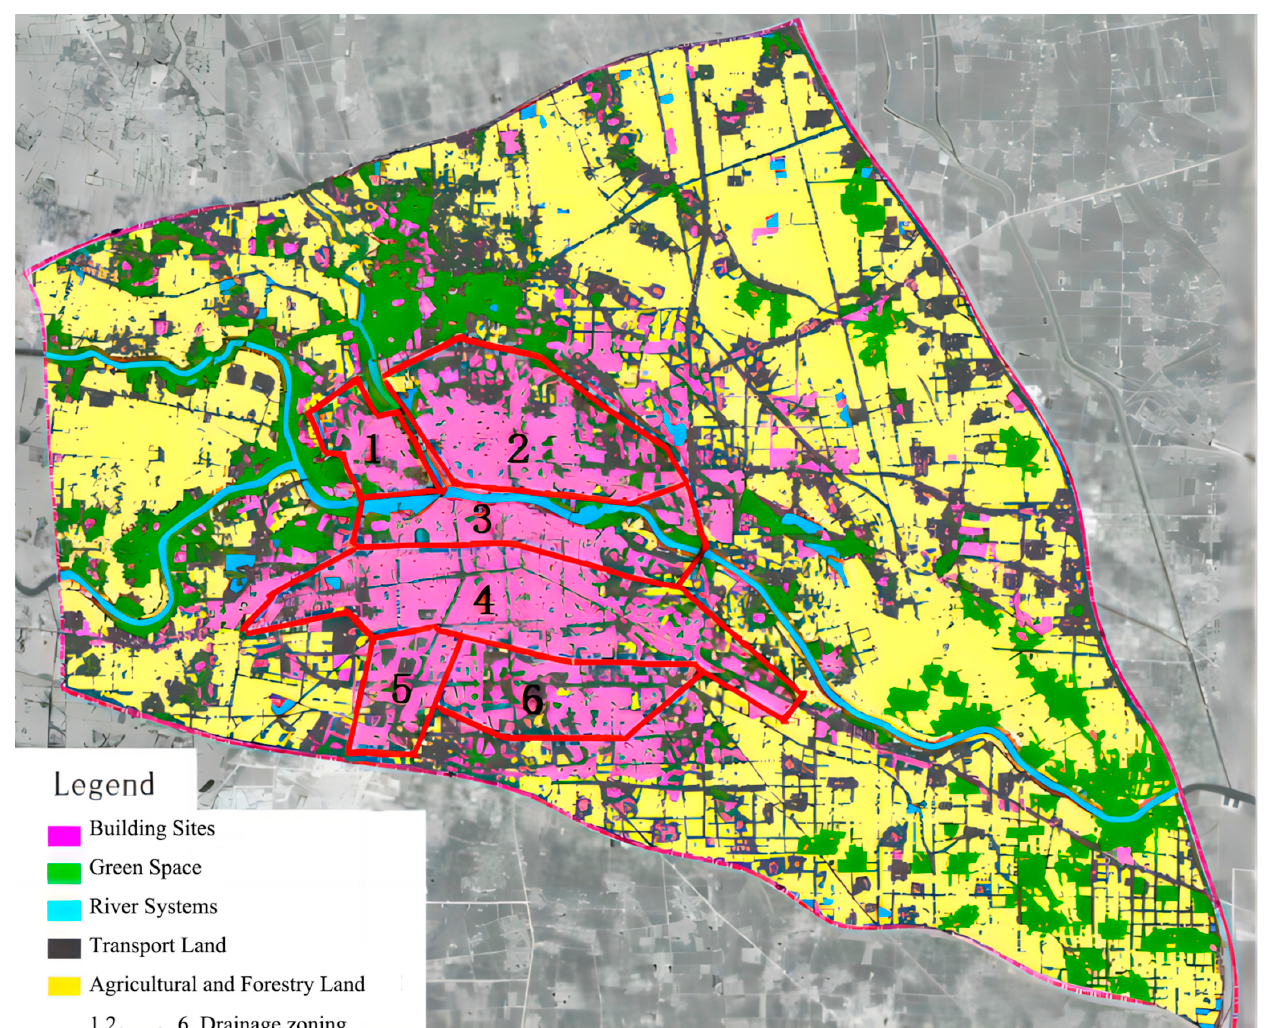
Figure 2. Map of the sub-bedding surface of the central city of Zhoukou. Table 1. Surface types (lower bedding surface) in the central city of Zhoukou.